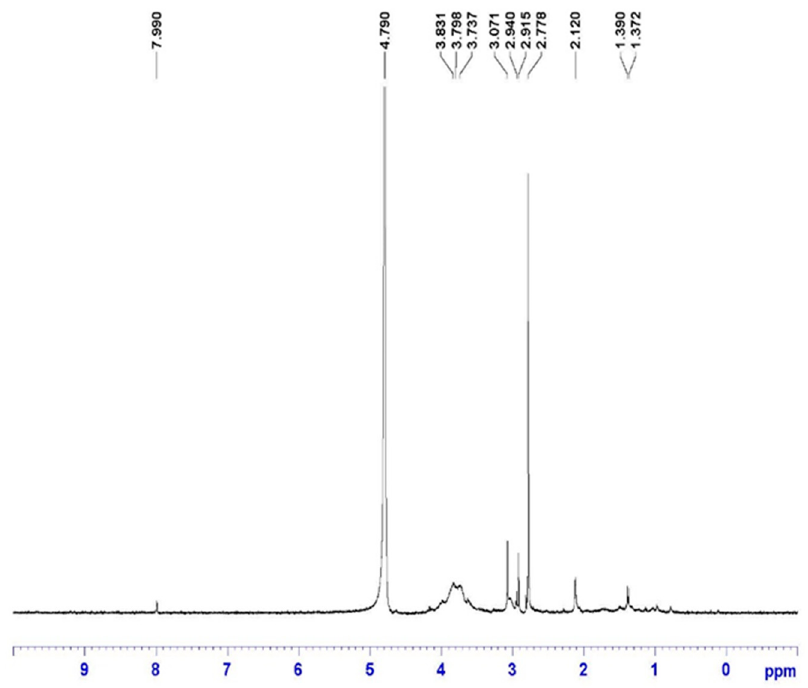
Figure 10. Proton NMR spectrum of lactose and cholic acid conjugated chitosan derivative 3 in D 2 O.